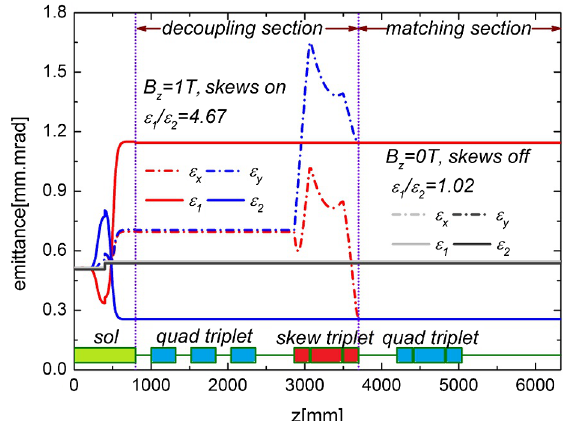
maps.FIG. 2. Evolution of the rms emittances and eigen-emittances along the EMTEX beam lines for two cases: in the first case (reference, gray and black lines) the solenoid and the skew quadru- poles are off, i.e., no nonsymplectic action nor coupling. Eigen- emittances and rms emittances are always equal and they change justduringthestrippingfrom angularscattering.Inthesecond case (red and blue lines) the solenoid field is 1.0 Tand its fringes cause nonsymplectic actions that change the eigen-emittances. Eigen- emittances and rms emittances separate and both are increased during stripping. The skew quadrupoles are turned on as well and remove the coupling previously produced inside of the solenoid. Since skew quadrupoles are symplectic, they do not change the eigen-emittances. After this decoupling the rms emittances are equal to the nonsymplectically changed